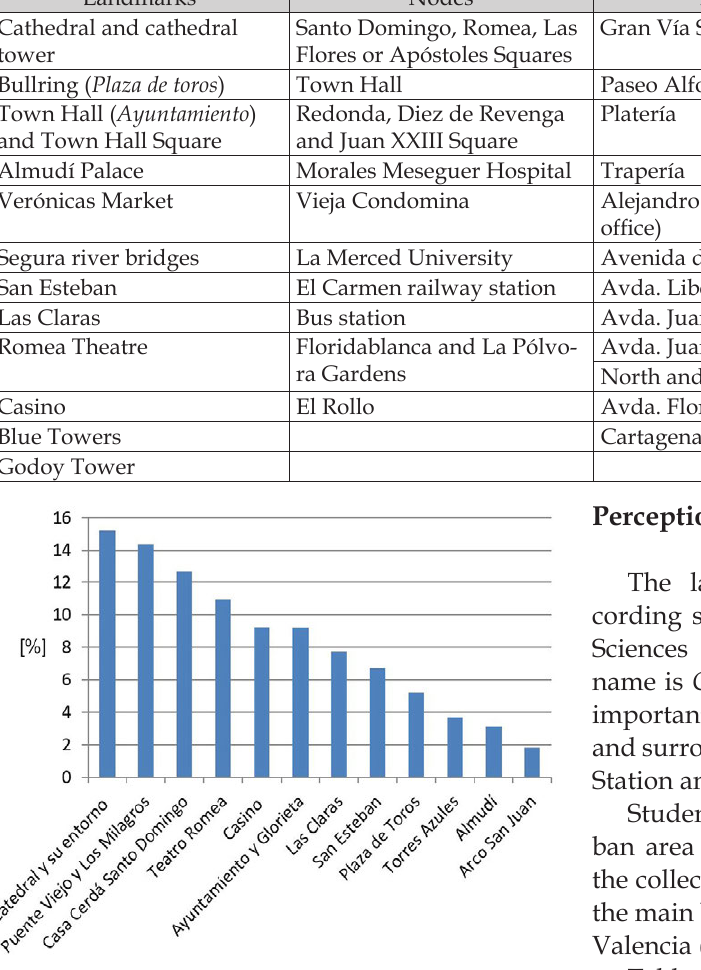
Fig. 4. Murcia landmarks according to survey results (% of the total